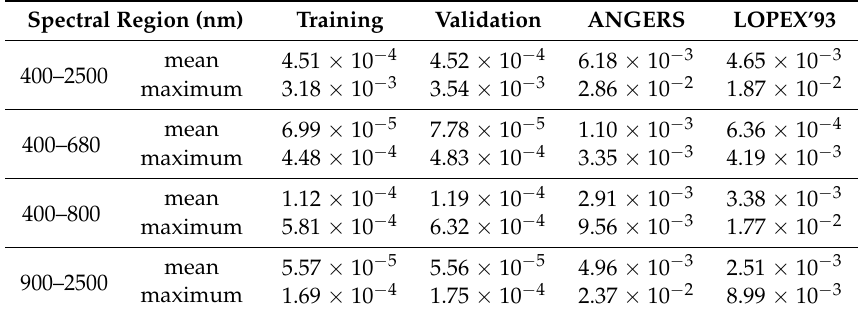
Table 3. The spectral root mean squared error (RMSE) value of the reconstructed reflectance spectra derived using the ten leading principal components (PCs) for different spectral regions.